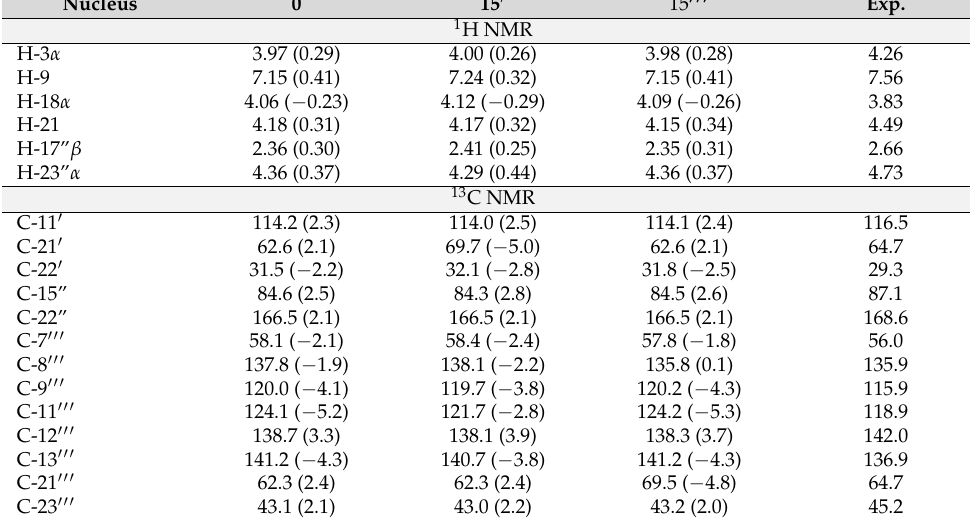
Table 1. Selected ambiguous cases of calculated NMR chemical shifts (ppm) of the key configurations 0, 15 (cid:48) , and 15 (cid:48)(cid:48)(cid:48) of alasmontamine A. The errors of the performed calculations are given in